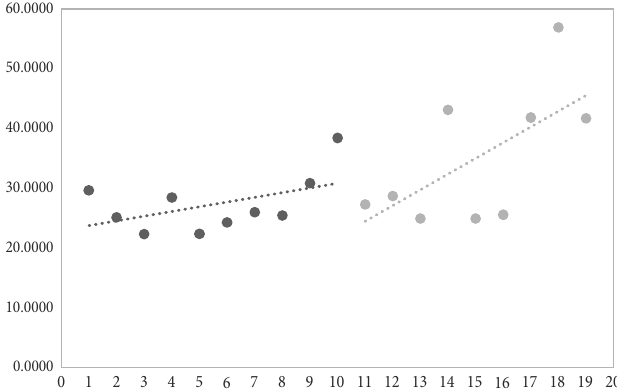
Fig. 4. Return on equity analysis: x axis – intangibles level groups in ascending order; y axis – mean value of ROE; (polynomial regression – Fig. 1A) Source: authors.